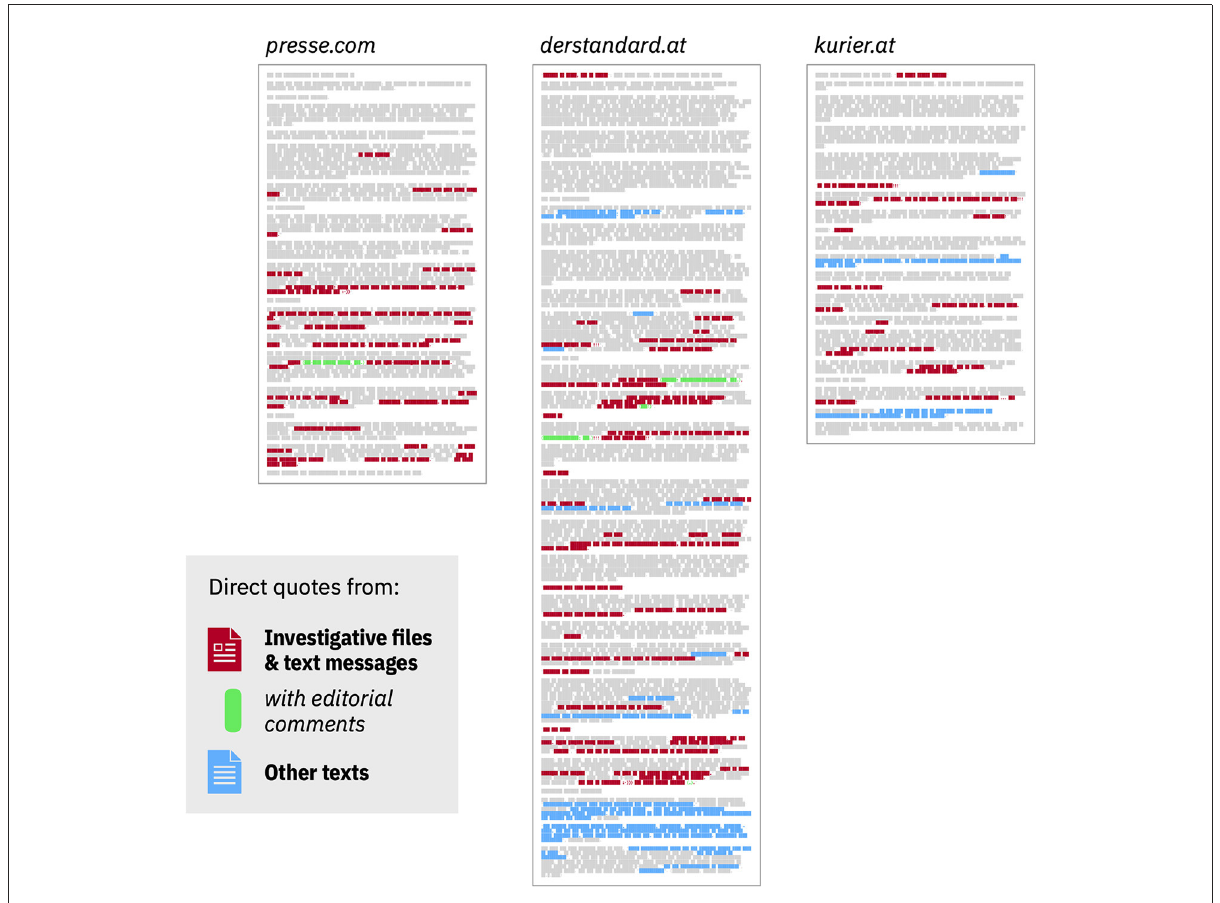
FIGURE2 Procedures of textual replay in three news